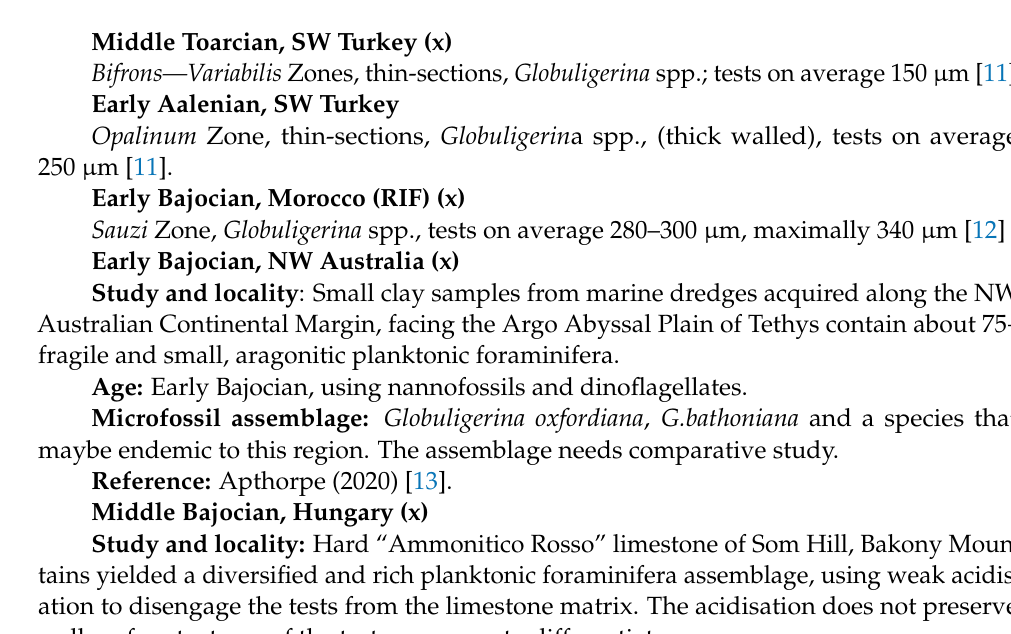
Figure 3. Approximate occurrence of Jurassic planktonic foraminifera in the Tethyan—sub Tethyan marine belt; see [1,3] for